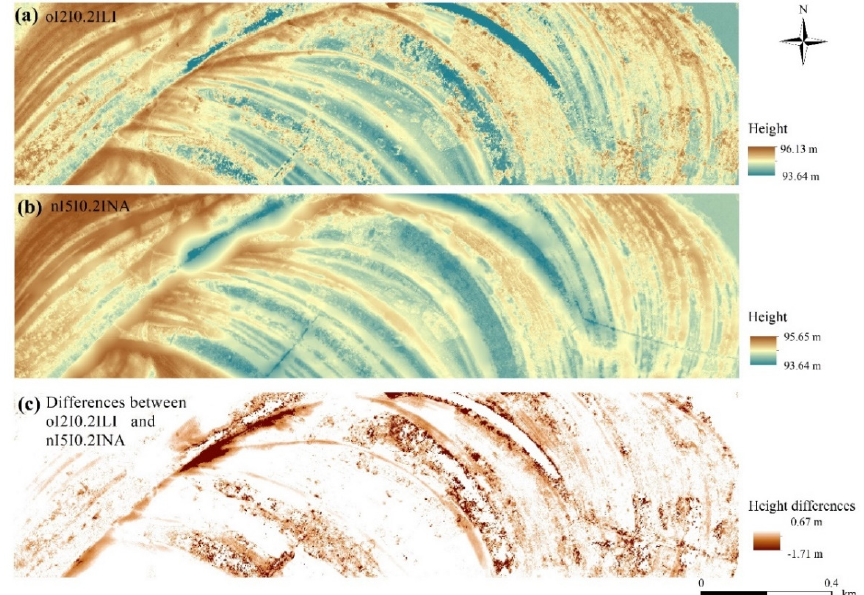
Figure 7. The best and the worst models according to the range of medians and the differences